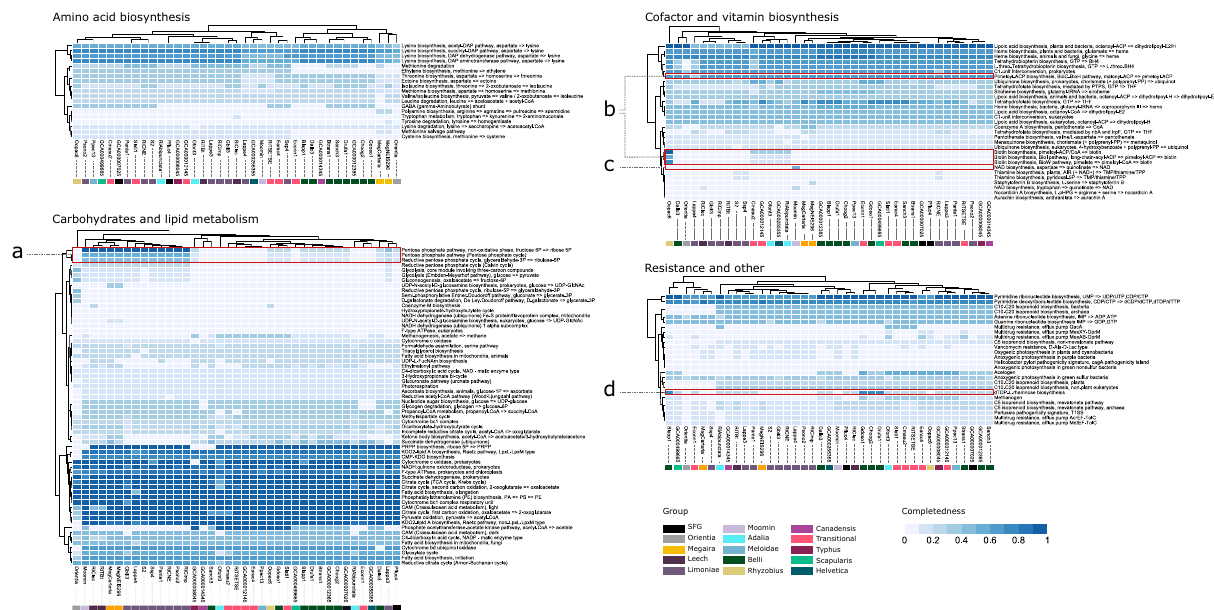
Fig. 5 Comparison of metabolic potential across selected Rickettsia and ‘ Ca . Megaira ’ . Heatmaps of predicted KEGG pathway completion estimated in Anvi ’ o 7, separated by function, and produced with Pheatmap. High to low completeness is coloured dark to light blue. Species groups are indicated with a unique colour as shown in the legend. Pathways of interest are highlighted in red: a The pentose phosphate pathway only present in Torix and ‘ Ca . Megaira ’ , b The biotin pathway present only in the Rhyzobius Rickettsia Oopac6. c NAD biosynthesis only present in Moomin Rickettsia. d dTDP ‐ L ‐ rhamnose biosynthesis pathway in Gdoso1, Choog2, Drufa1, and Blapp1. SFG is Spotted Fever Group. Source data are provided in Source